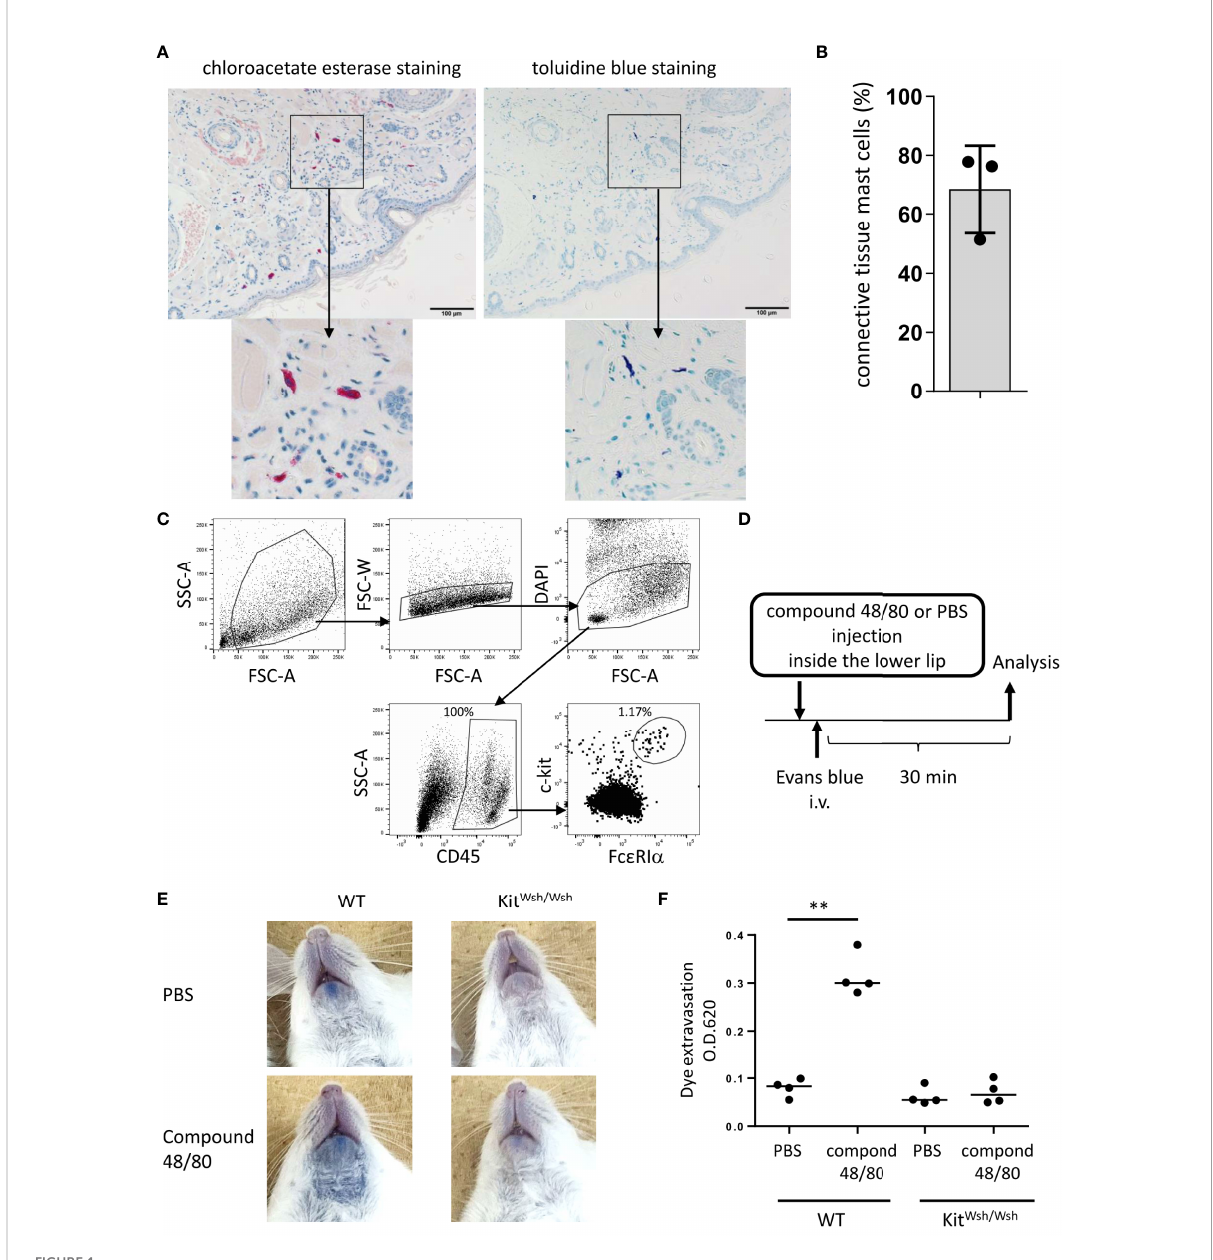
FIGURE 1 Development of murine model of pseudo-allergic reaction in the oral cavity. (A, B) Chloroacetate esterase staining or toluidine blue staining of serial tissue sections in the inside of the lower lip from Balb/c mice (n = 3) under steady conditions. (A) Chloroacetate esterase-stained (left panel) or toluidine blue-stained (right panel) mast cells are seen. (B) The percentage of both chloroacetate esterase- and toluidine blue-stained mast cells among chloroacetate esterase-stained mast cells. The total count was 59, 33, or 45 mast cells in serial tissue sections from three mice. Data are representative of two independent experiments. (C) Surface expression levels of Fc e RI a and c-Kit among CD45 + hematopoietic cells in the inside tissue of the lower lip from Balb/c mice under steady conditions. Fc e RI a + c-Kit + mast cell populations (1.17%) among CD45 + cells (100%) were seen. Data are representative of three independent experiments. (D) A schematic representation of murine models of compound 48/80-induced pseudo-allergic reaction in oral cavities. (E) Injection of compound 48/80 inside the lower lip caused dye extravasation in the skin from WT mice but not from Kit W-sh / W-sh mice. Representative pictures of the neck skin from WT mice injected with compound 48/80 (left/lower) or PBS (left/upper) and from Kit W-sh / W-sh mice injected with compound 48/80 (right/lower) or PBS (right/upper) (F) Quanti fi cation of the Evans blue dye that extravasated into the neck skin from WT or Kit W-sh / W-sh mice injected with compound 48/80 or PBS. n =4 per group; data are presented as mean ± SD. Data are representative of two independent experiments. Brown-Forsythe and Welch ANOVA with Dunnett T3 multiple comparisons. ** P <